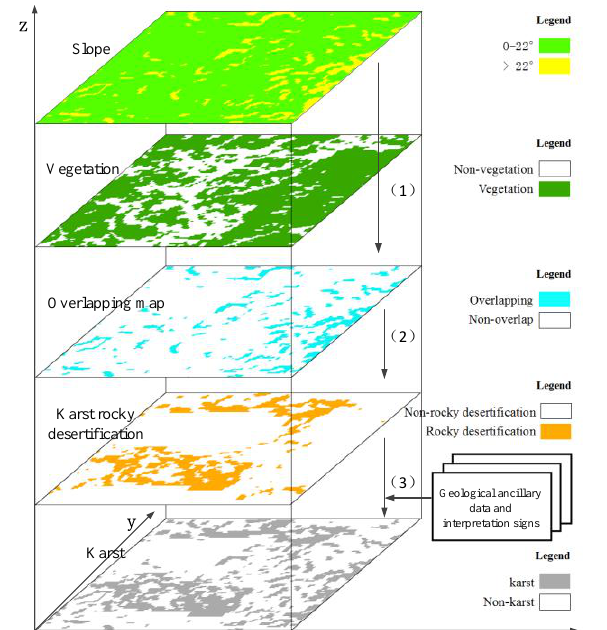
Figure 3. Human-computer interaction interpretation